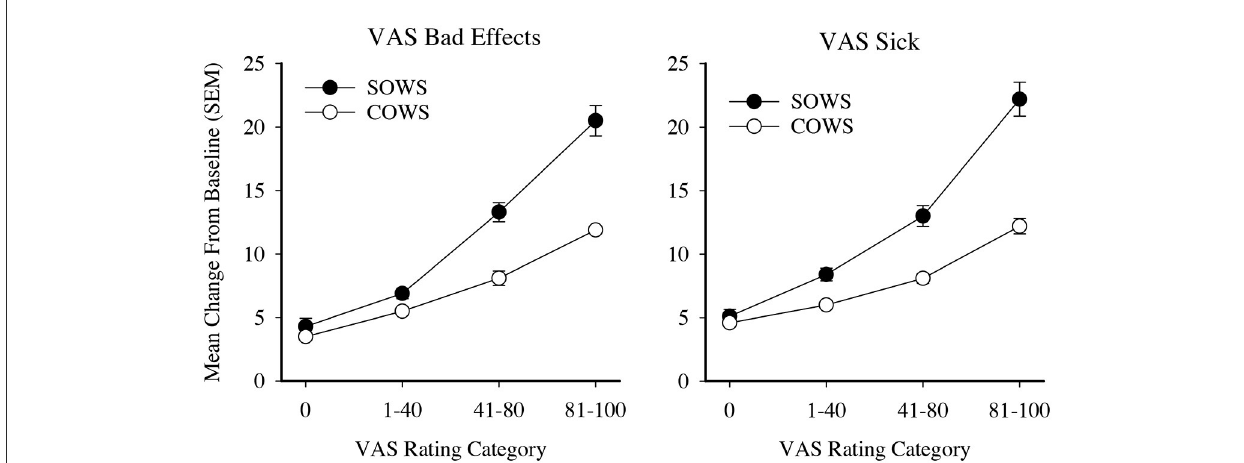
FIGURE2 Visual analog ratings (VAS) as severity scores. Data present severity categories for the self-reported Subjective Opiate Withdrawal Scale (SOWS, filled circles) and observer-rated Clinical Opiate Withdrawal Scale (COWS, open circles). All data points are significantly different from each other within each scale and outcome